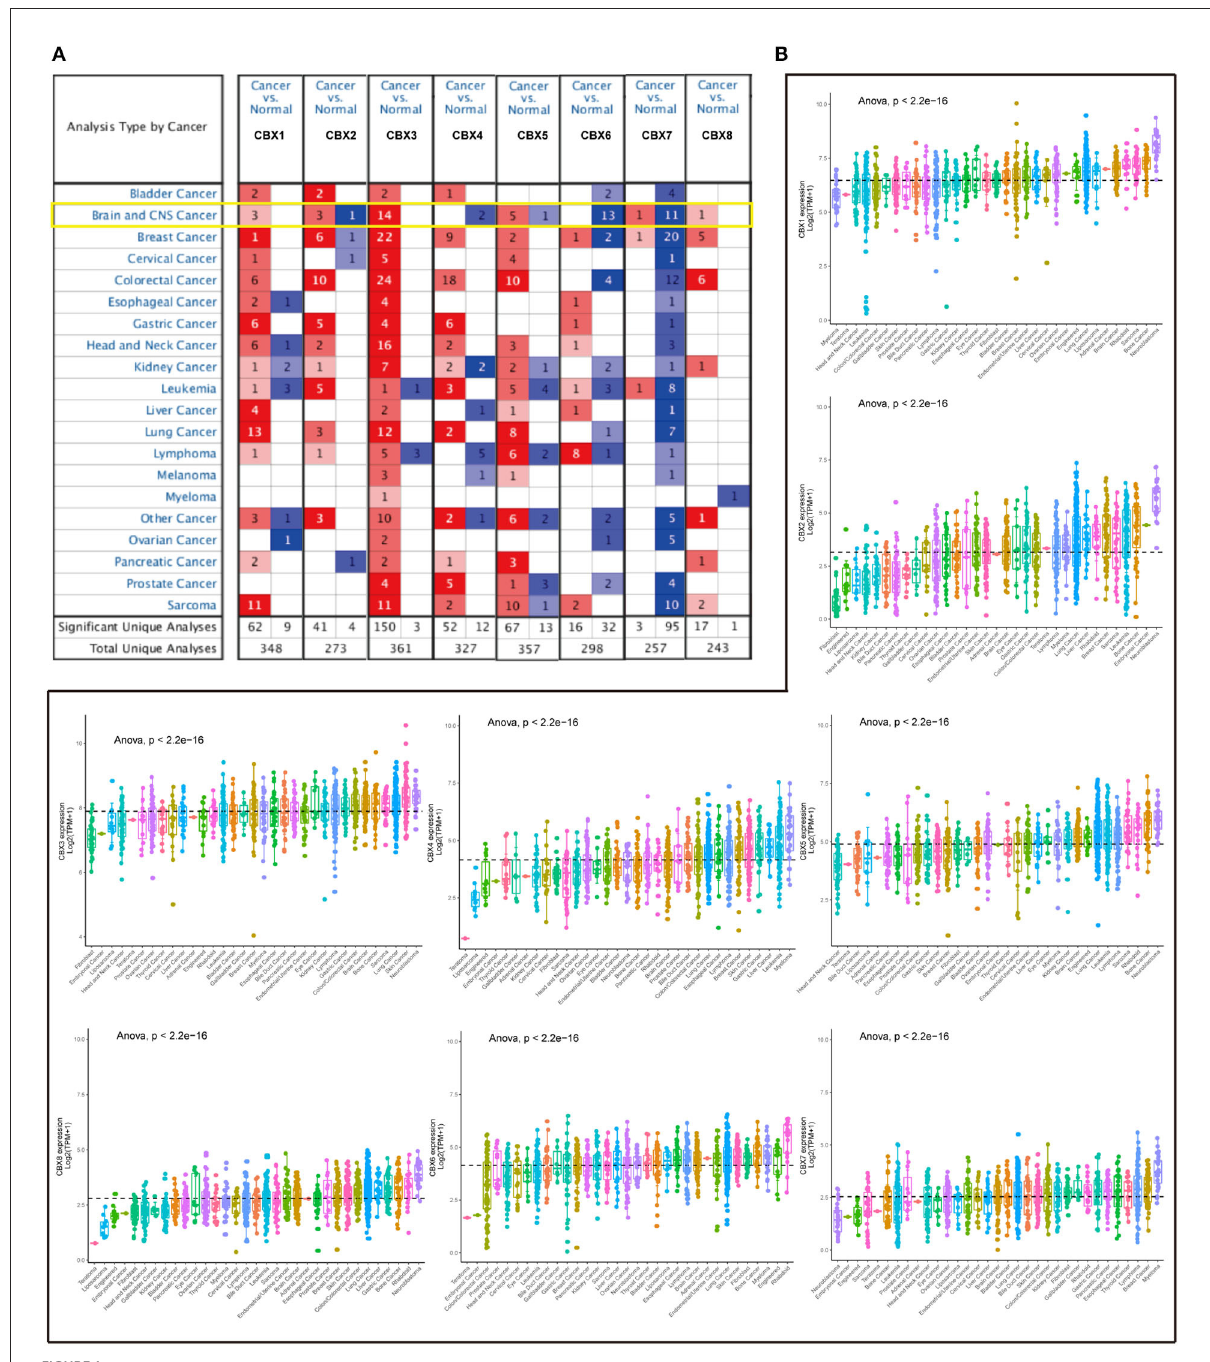
FIGURE1 mRNA expression of CBX family in different cancers from tissues to cell lines. (A) Transcriptional expression of CBXs in 20 different types of cancers tissues (ONCOMINE). The difference in transcriptional expression was analyzed by Student’s t -test. The cut-off of p -value was below 0.05. Fold changes should be beyond 1.5, and gene ranks should be in the top 10%. The yellow box emphasized the Brain and CNS cancers. (B) The difference of each CBX member at mRNA level in cell lines (CCLE) of 33 various cancers. Statistical comparisons were performed using one-way ANOVA and post hoc least significant difference tests for multiple comparisons. The dashed line represented the mean of the expression in the above 33